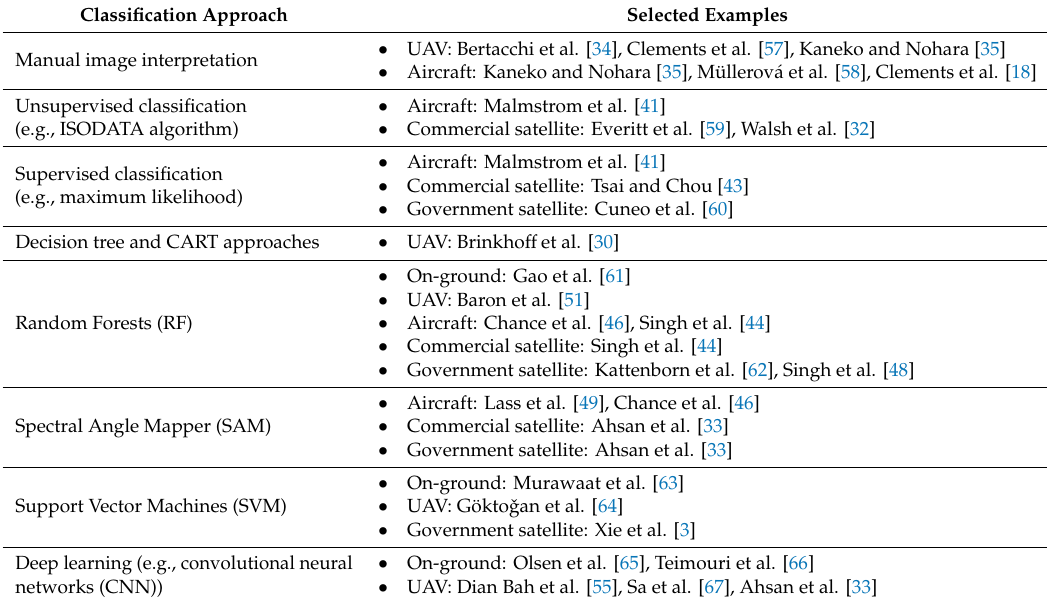
Table 2. Examples of image classification approaches (grouped by remote sensing platform) used in weed detection